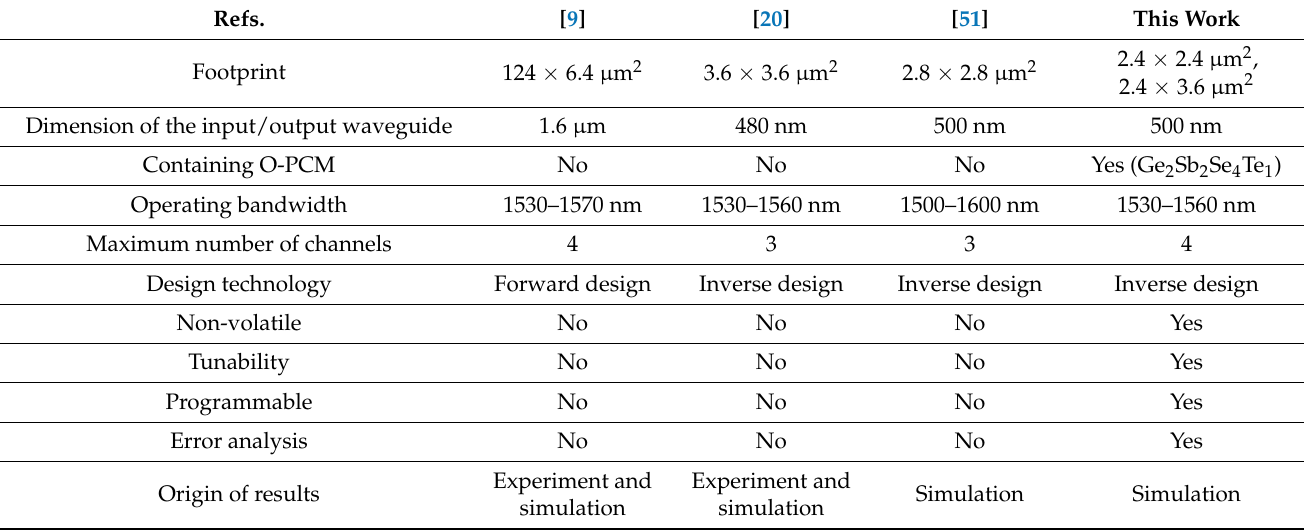
Table 4. Structural parameters and performance of arbitrary power splitters.